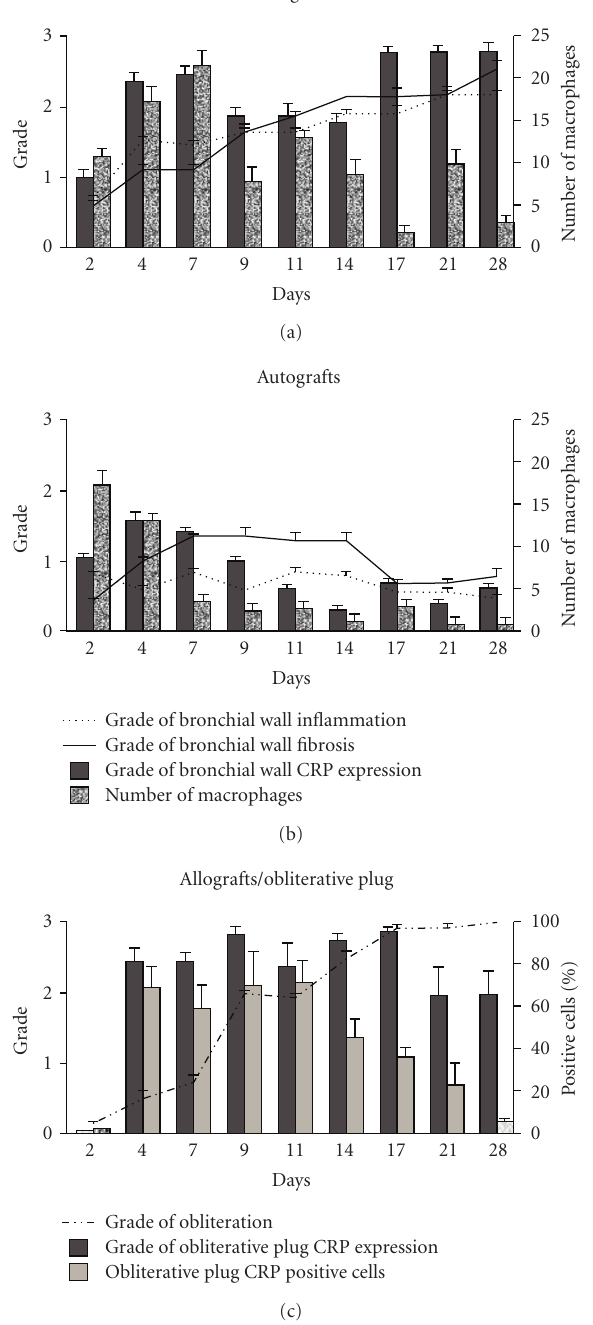
Figure 1: Bronchial wall alterations in bronchial allografts and autografts and alterations in the obliterative plug. Variables deter- mining the histological grade of inflammation and fibrosis of the bronchial wall are given for bronchial allografts and autograft controls together with the intensity of immunocytochemistry against CRP, all on a scale from 0–3. In addition, the number of macrophages (MP) in the bronchial wall is given for allografts and autografts. Cells are counted per high power visual field. The histological grade of luminal obliteration (0–3) is given for allografts together with the percentage of cells positive for CRP in the obliterative plug and with the intensity score of the staining. Autografts remained patent with no observed obliterative